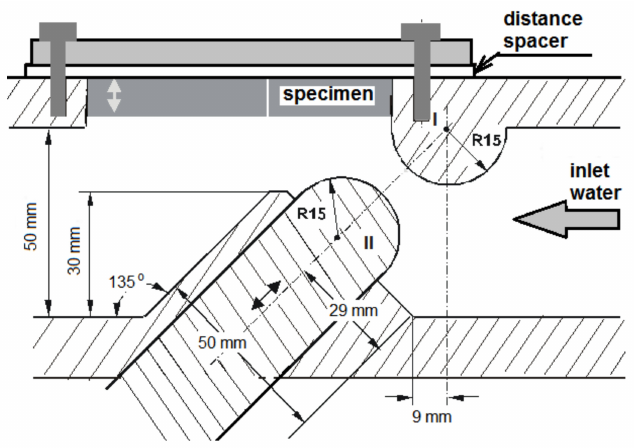
Figure 1. Scheme of the cavitation tunnel.